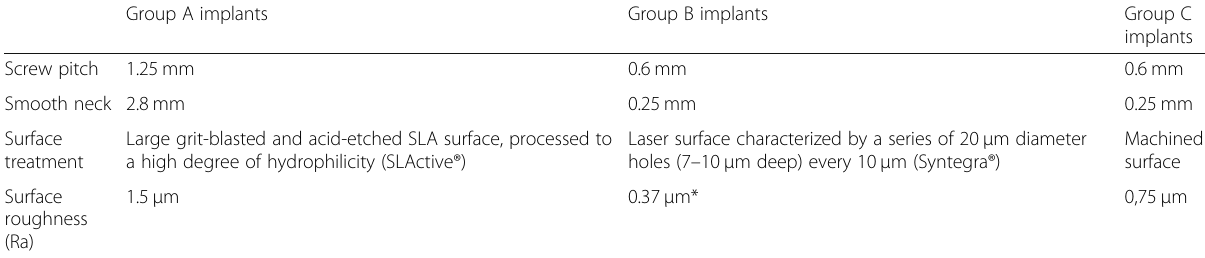
Table 1 Implants details of both groups: screw pitch, smooth neck length, surface treatments, and roughness